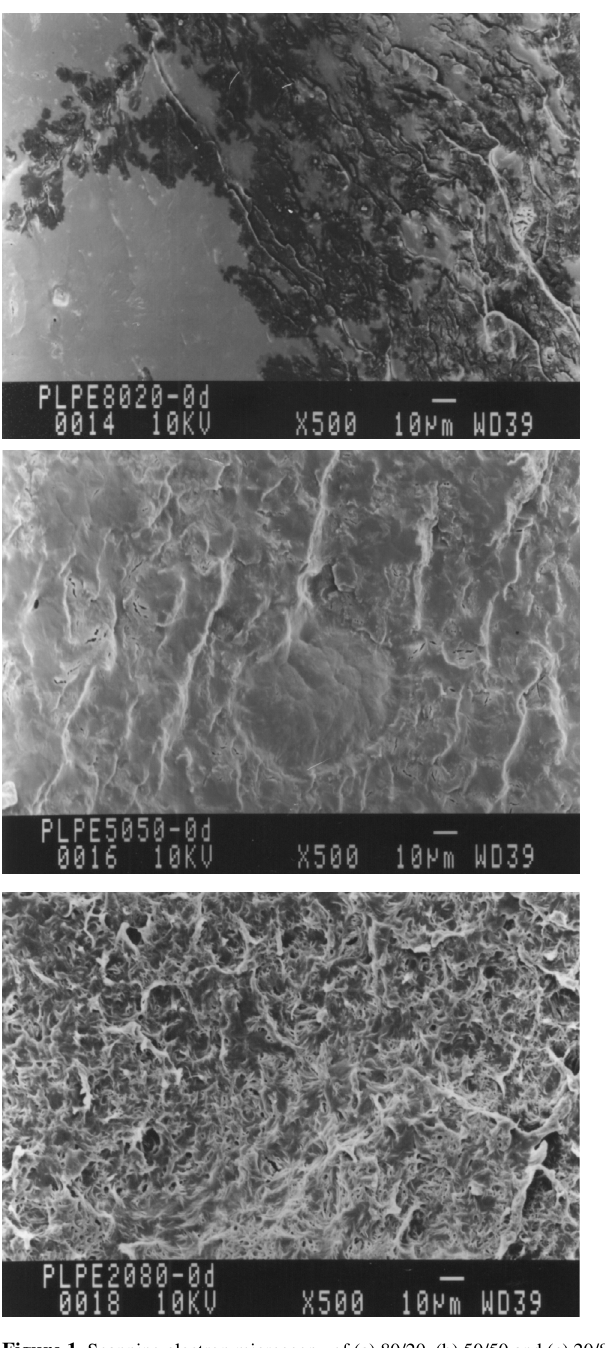
Figure 1. Scanning electron microscopy of (a) 80/20, (b) 50/50 and (c) 20/80 PLLA/PEO blends t = 0 (left hand side) and t = 14 days (right hand